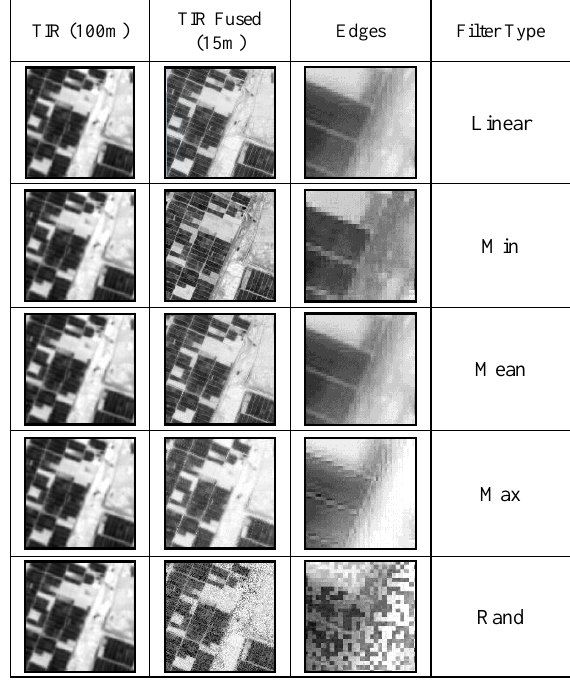
Figure 3. Visual results of different filters RESULTS AND